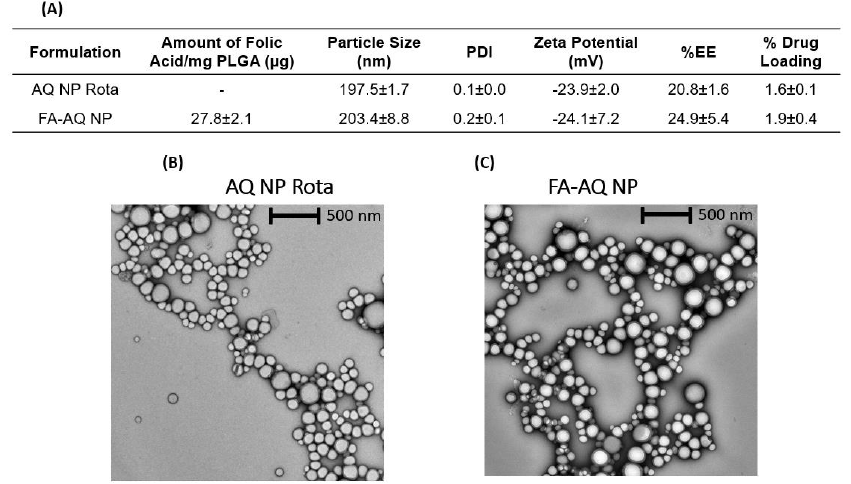
Figure 2. ( A ) Characterization of non-targeted and targeted nanoparticles. ( B , C ) Transmission electron microscopy (TEM) images of AQ NP Rota and FA-AQ NPs. The scale bar represents 500 nm. Magnification 20 k ×